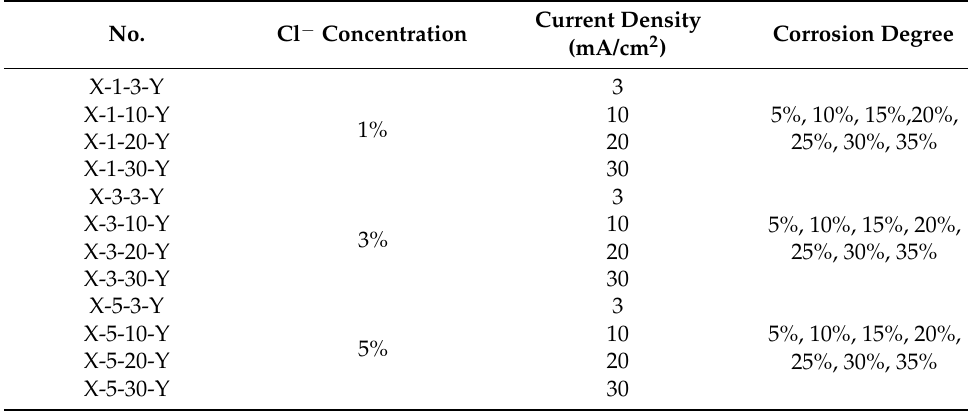
Table 1. Electrified corrosion test